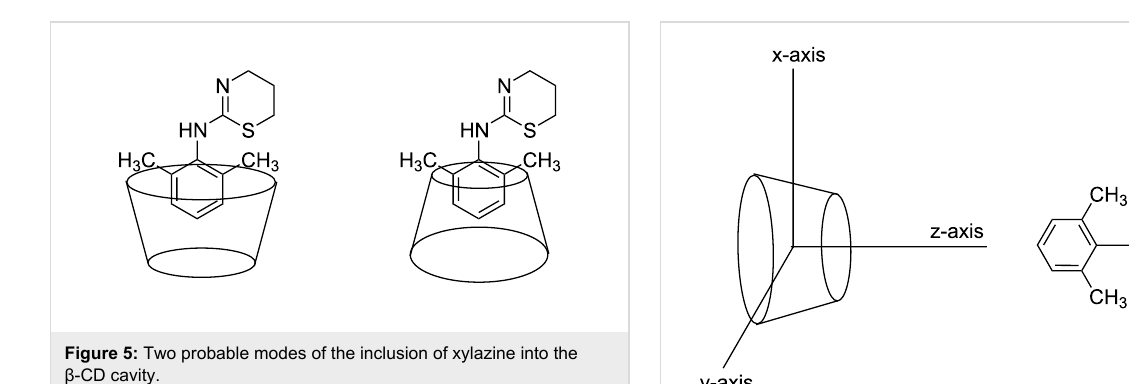
of xylazine near the mouth of the β -CD cavity along the z-axis either on the narrow (N) or wide (W) side (Figure 6).